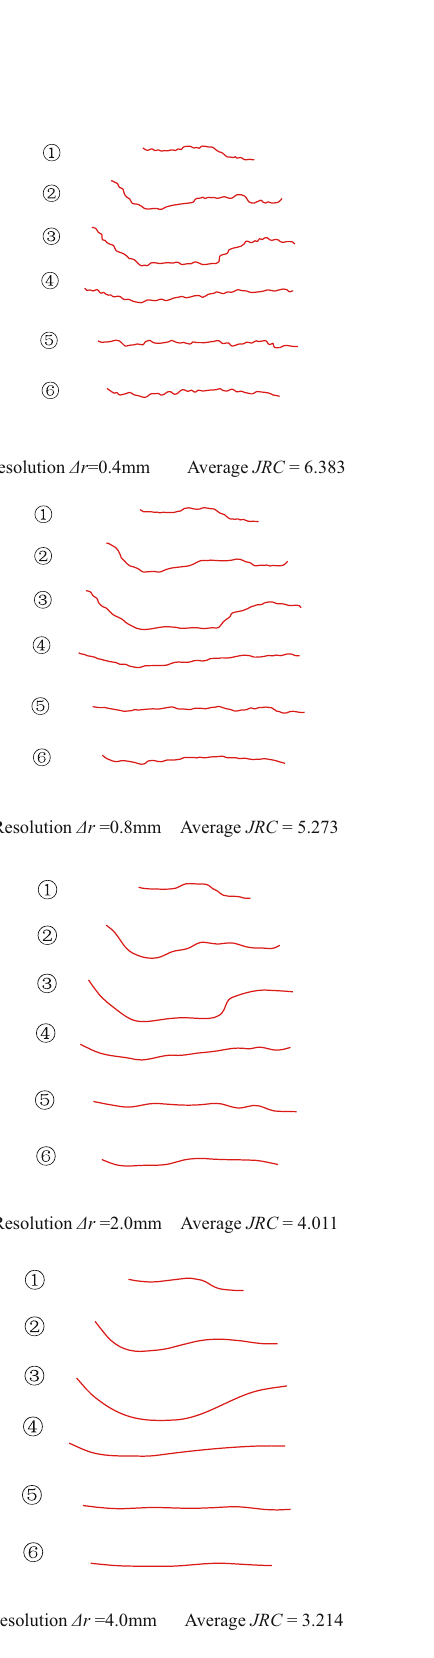
Figure 10: Sectional morphology and JRC value at di ff erent